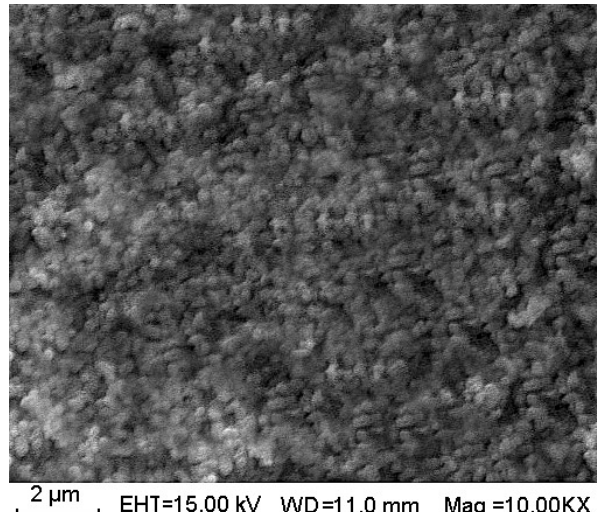
Figure 9. SEM images of 3 mol % Ce 4+ doped SrTiO 3.